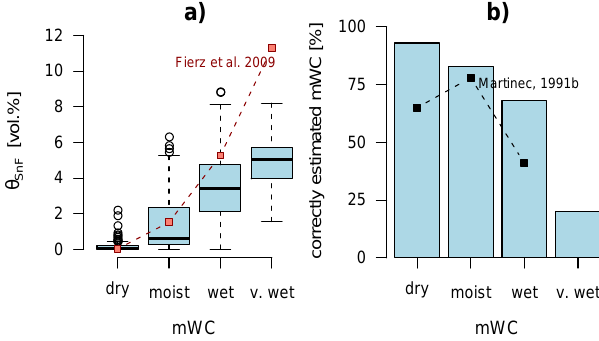
Fig. 7. (a) Box-plot comparing estimated liquid water content Fig. 7. a) Box-plot comparing estimated liquid water content (mWC) and water content measured with the Snow Fork ( θ SnF , (mWC) and water content measured with the Snow Fork ( θ SnF , n = 318, 4 observers). As comparison the mean for each class n=318, 4 observers). As comparison the mean for each class is is shown based on the conversion given in Fierz et al. (2009). shown based on the conversion given in Fierz et al. (2009). b) shows (b) shows the frequency that mWC was correctly estimated (light the frequency that mWC was correctly estimated (light blue bars). blue bars). For comparison, data by a previous study is shown For comparison, data by a previous study is shown (black dashed (black dashed line, black squares Martinec, 1991b, n = 518, 9 ob- line, black squares Martinec, 1991b, n=518, 9 observers). θ SnF is servers). θ SnF is corrected by − 0.8vol.% (this corresponds to the corrected by -0.8 vol.% (this corresponds to the median offset in dry median offset in dry snow).